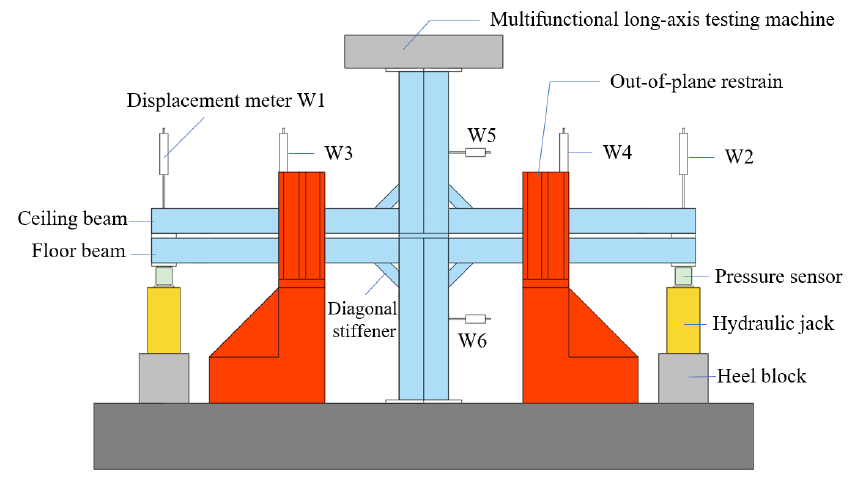
Figure 10. Loading devices.